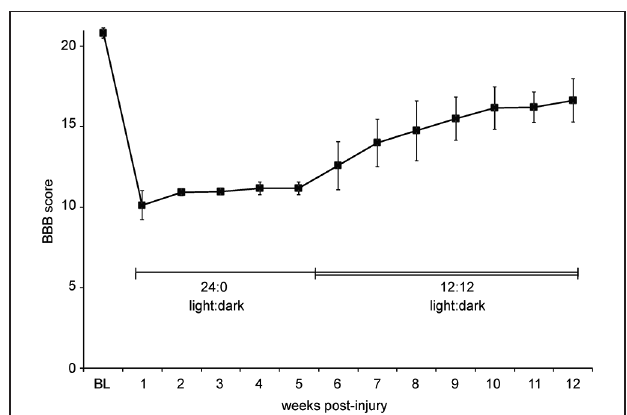
FIGURE 3 | Abnormal light: dark cycle impairs locomotor recovery. Graph shows BBB scores over time for a group of eight female SD rats housed in pairs. Due to a malfunction, we believe that the animals were in constant light (24:0, light:dark) starting 1 day post-injury until the 12:12, light:dark cycle was restored at 5 weeks post-injury. Data is shown as mean ± SD.